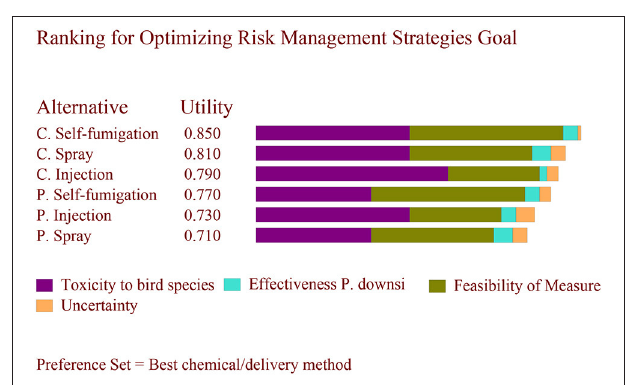
FIGURE 3 | Ranking of the six alternatives considering the weights from Scenario